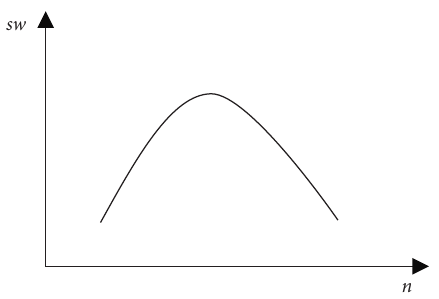
Figure 2: The diagram of the inverted U-shaped